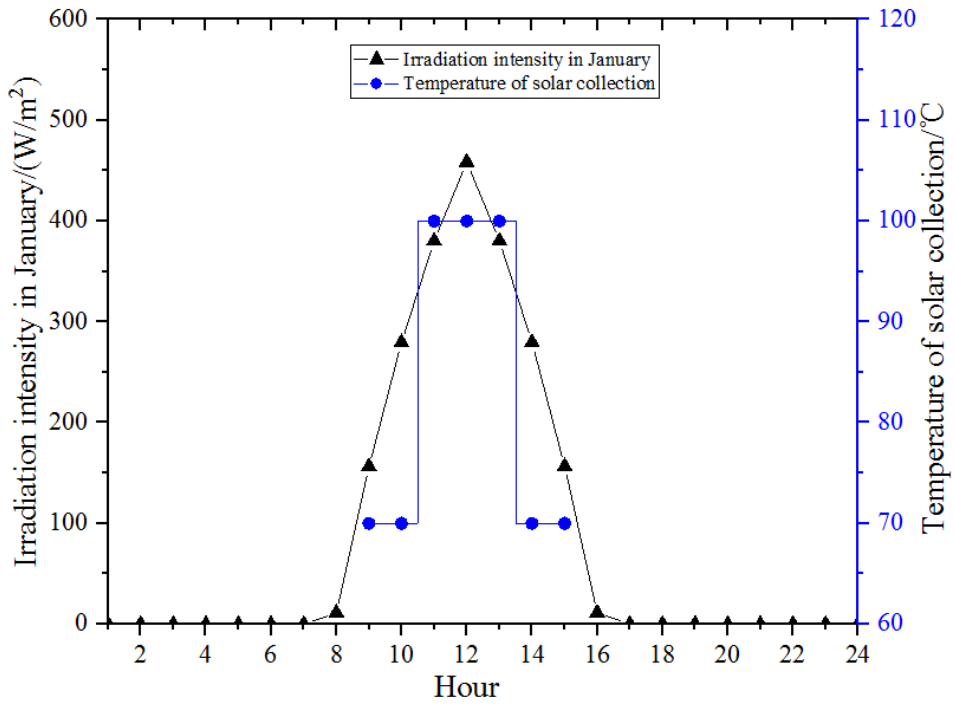
Figure 10. Schematic of the temperature of solar collection on a typical day in January. The simulation results are listed in Table 4 under the specified conditions on a typical day of each month.